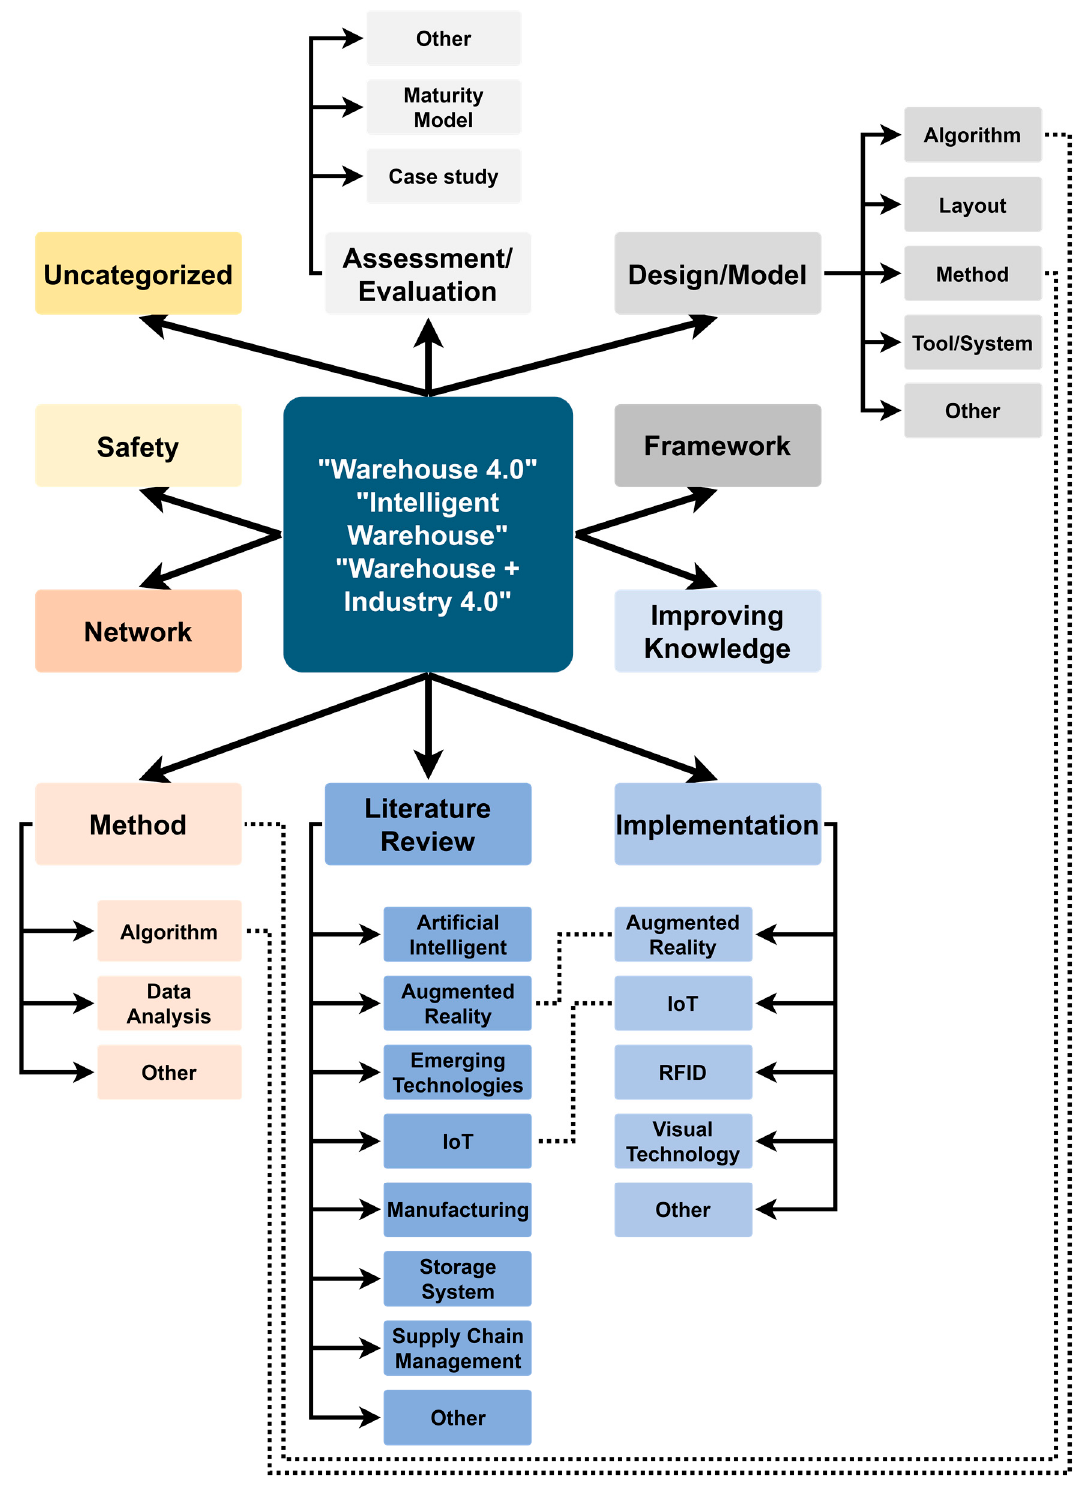
Figure 7. Category mapping of articles.